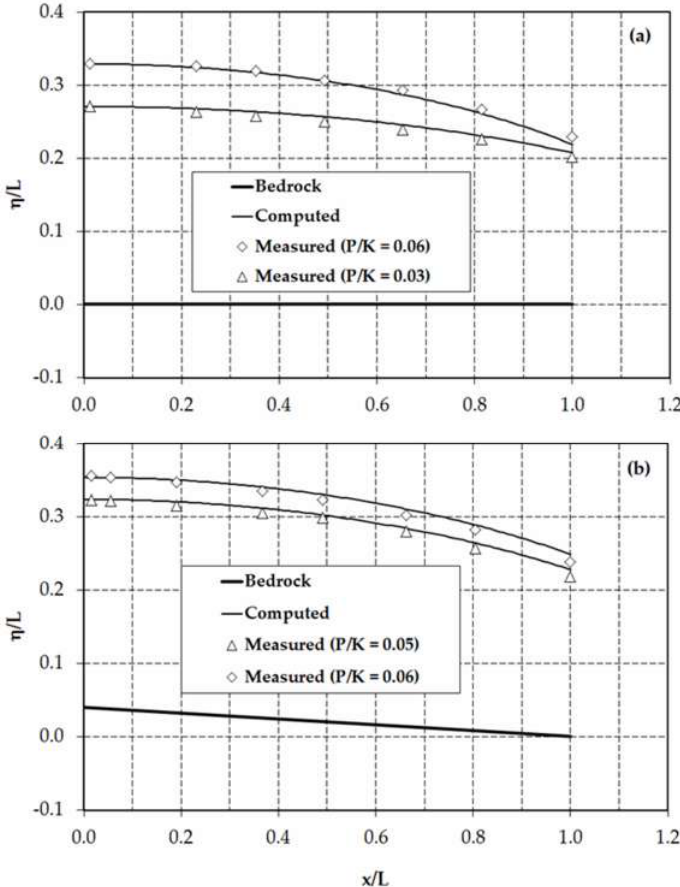
Figure 6. Recharge-induced unconfined groundwater flows over planar bedrock: ( a ) horizontal bedrock; and ( b ) bedrock slope = 2.03°.